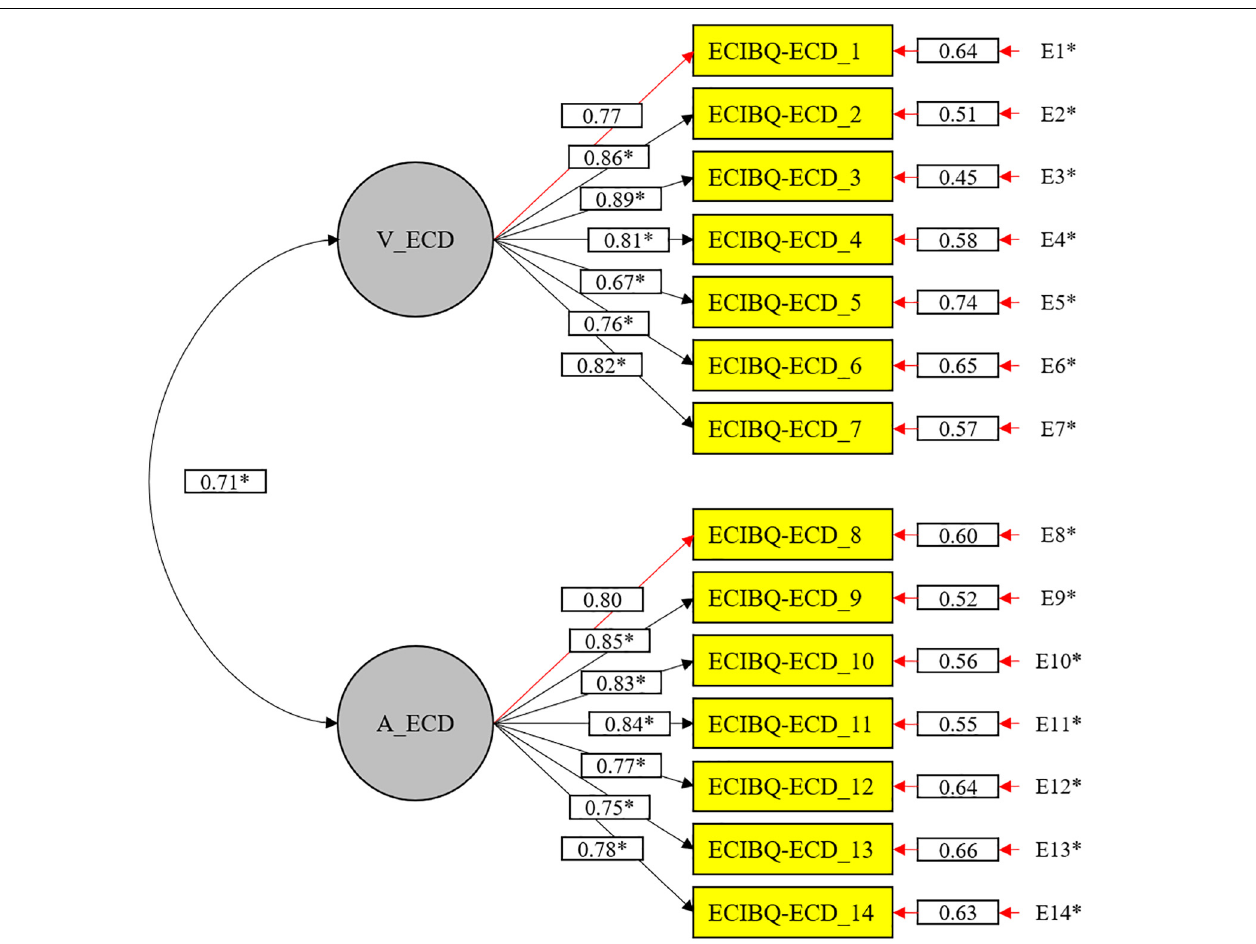
FIGURE 1 | CFA of the EBIPQ-ECD scale ( ∗ p < 0.05).